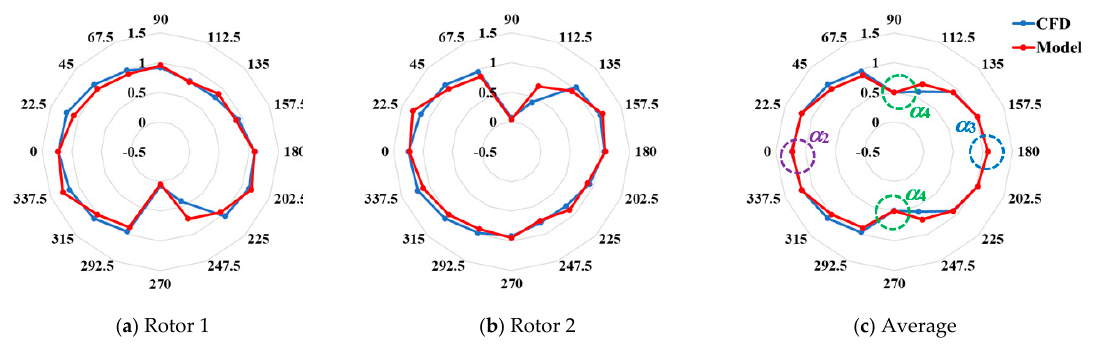
Figure 12. Distributions of normalized rotor powers in the IR − configuration in the case of gap = 1.0 D : ( a ) Rotor 1; ( b ) Rotor 2; ( c ) average.